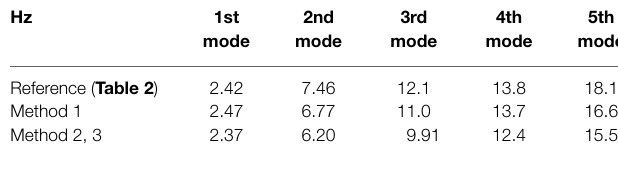
TABLE 4 | Natural frequencies of identified shear model